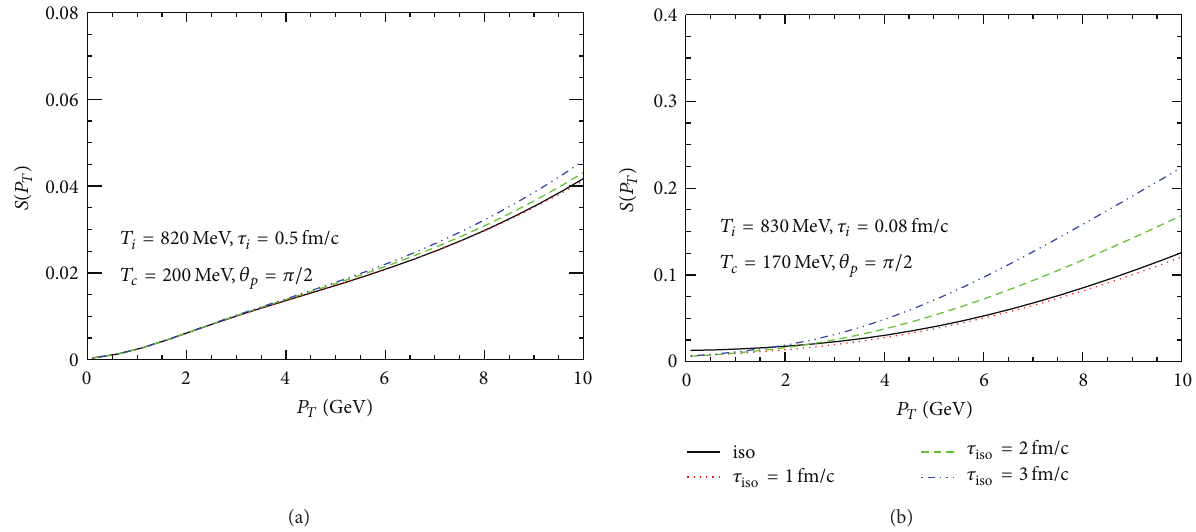
Figure 6: (Color online) The survival probability of 𝐽/𝜓 in an anisotropic plasma for the two sets of initial conditions at LHC energies. Left (right) panel corresponds to 𝑇 𝑐 = 200(170)